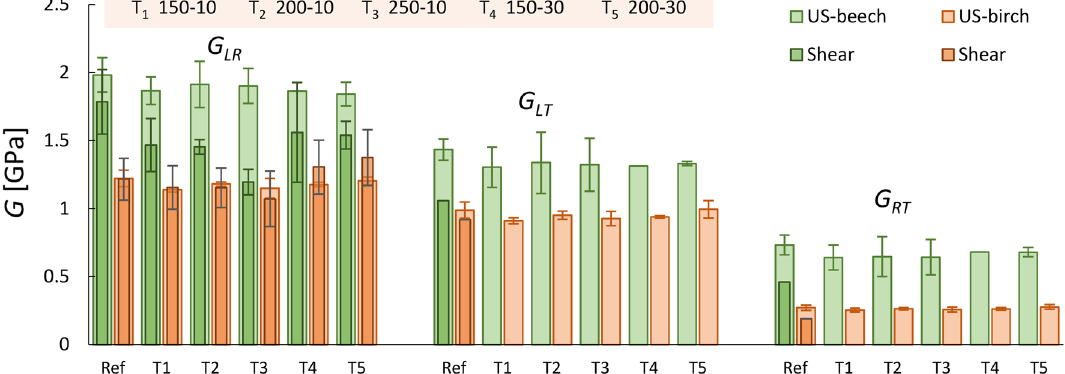
Figure 10. Mean values of the shear moduli of reference and heat-treated beech and birch obtained by ultrasound (US) and quasi-static tests (Co: compression; Te: